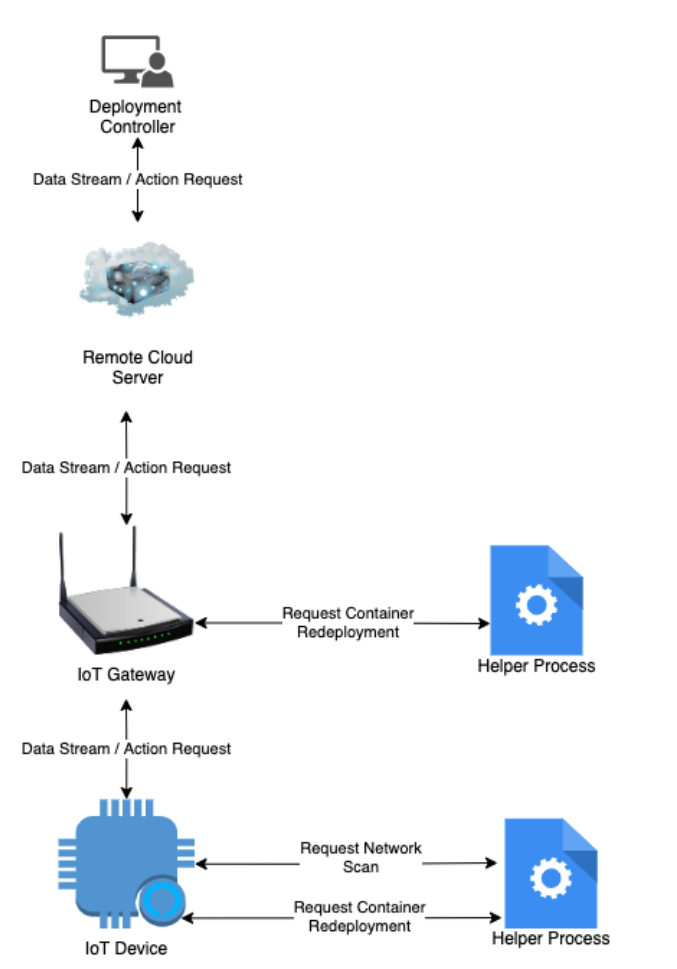
Figure 2. Proposed framework for IoT failure